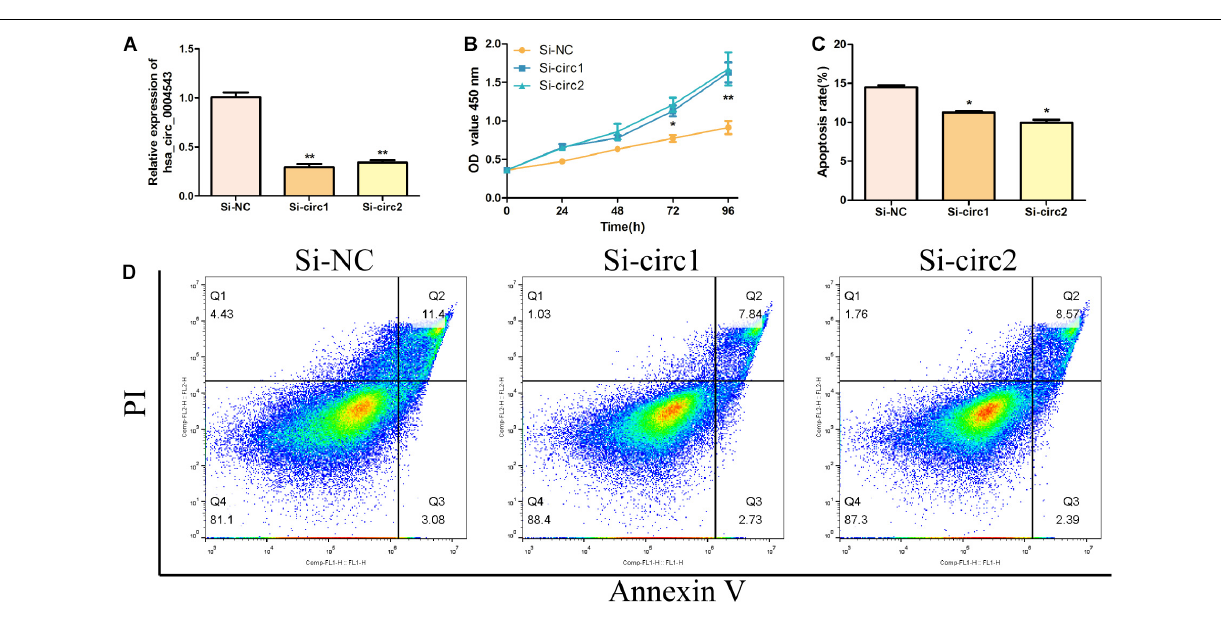
Frontiers in Genetics |